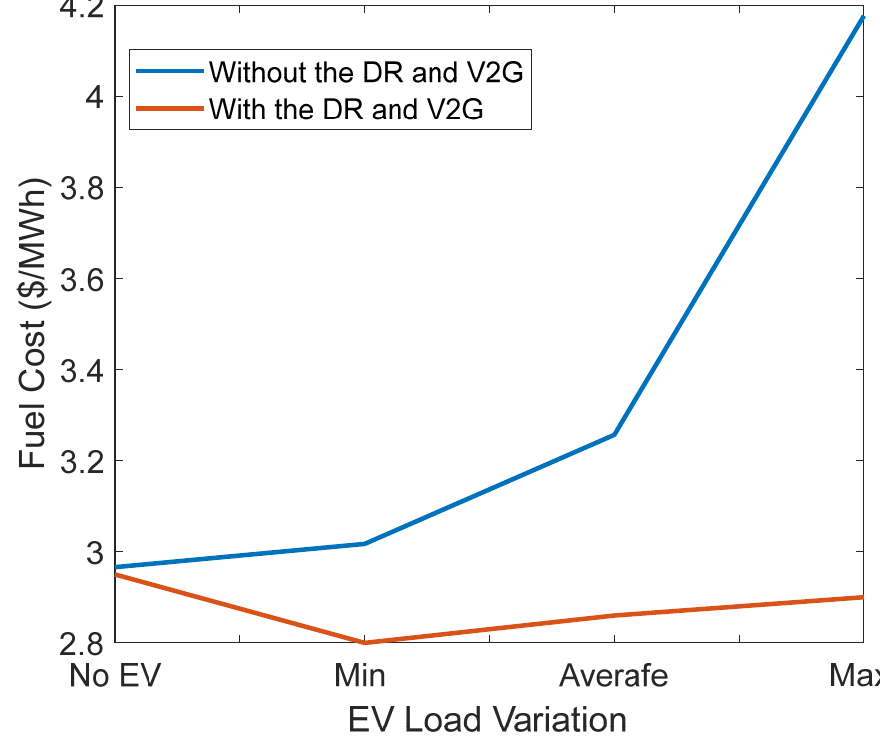
Figure 14. The variation of the fuel cost with and without the use of DR and V2G.